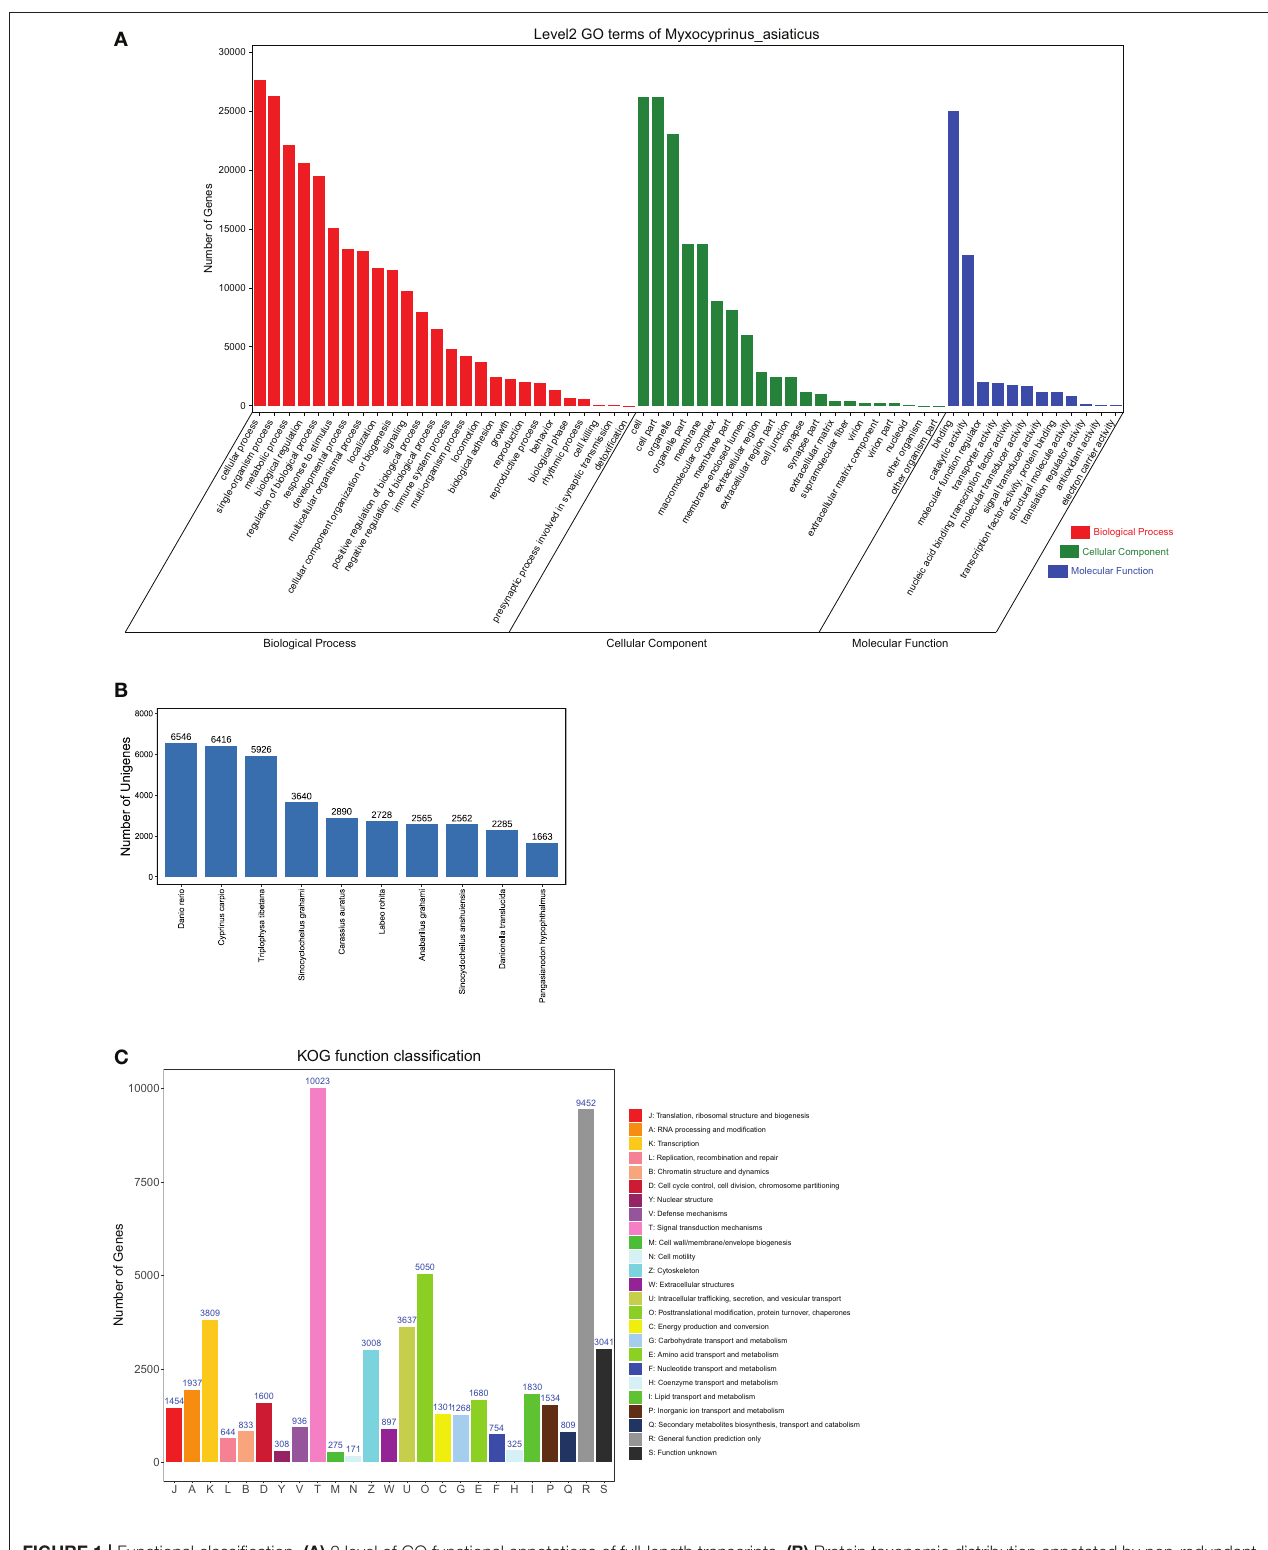
Frontiers in Marine Science |